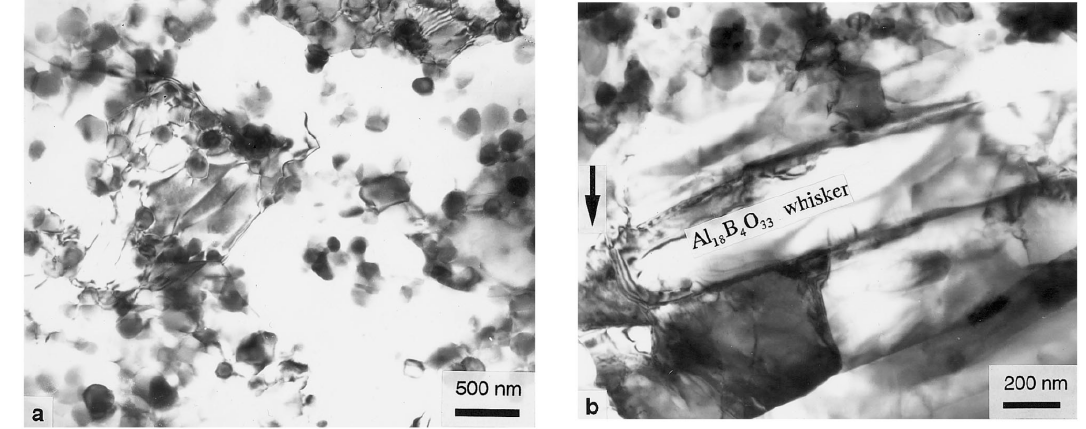
Figure 5. ( a ) TEM photographs showing dispersoids with dislocations. ( b ) AlBO whiskers after a creep test in [18,19].